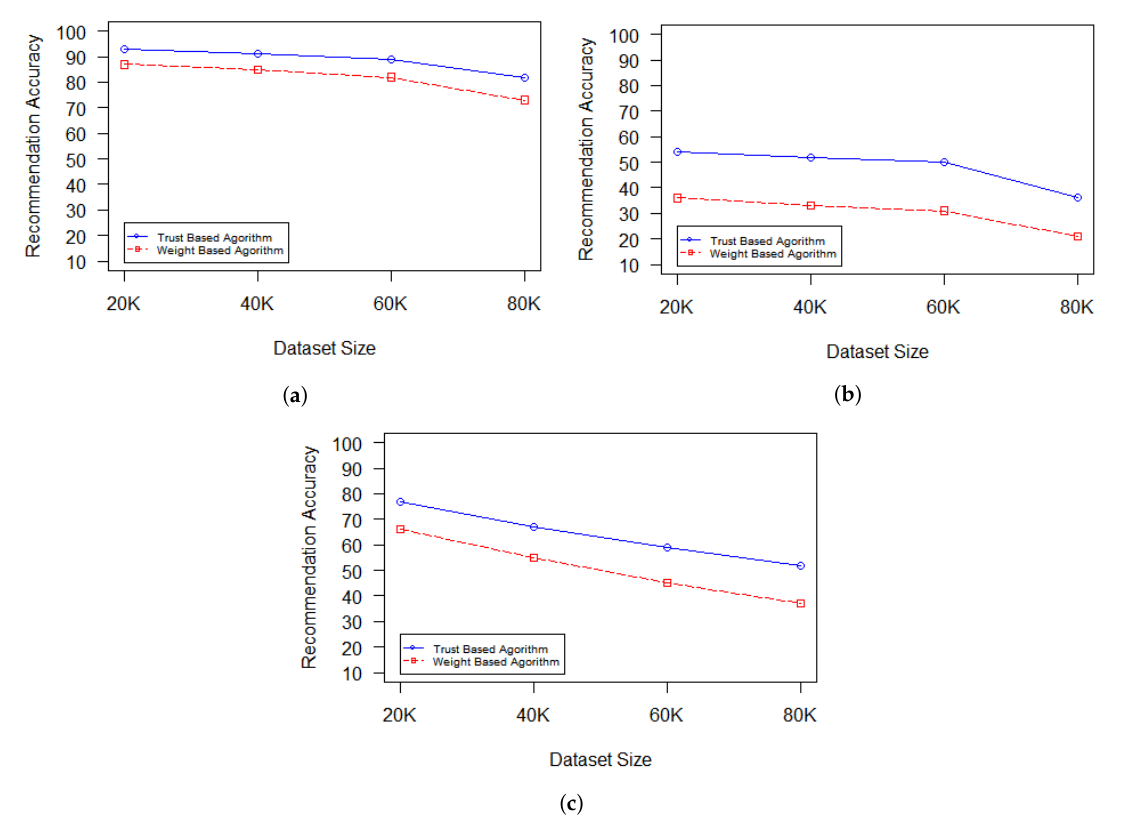
Figure 11. Effect of dataset size on recommendation accuracy. ( a ) BrightKite dataset; ( b ) Gowalla dataset; ( c ) Weeplaces dataset.